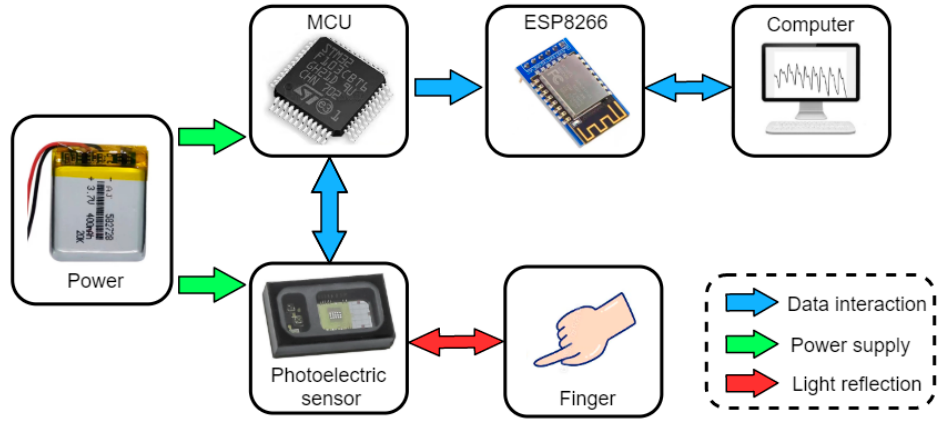
Figure 1. A fl owchart of the PPG data acquisition system. Figure 1. A flowchart of the PPG data acquisition system.